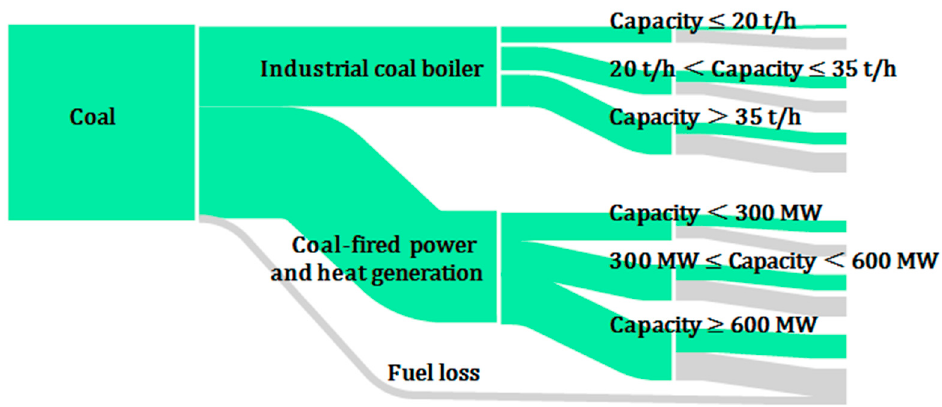
Figure 4. Schematic diagram of the “Dual Structure” of coal in China.